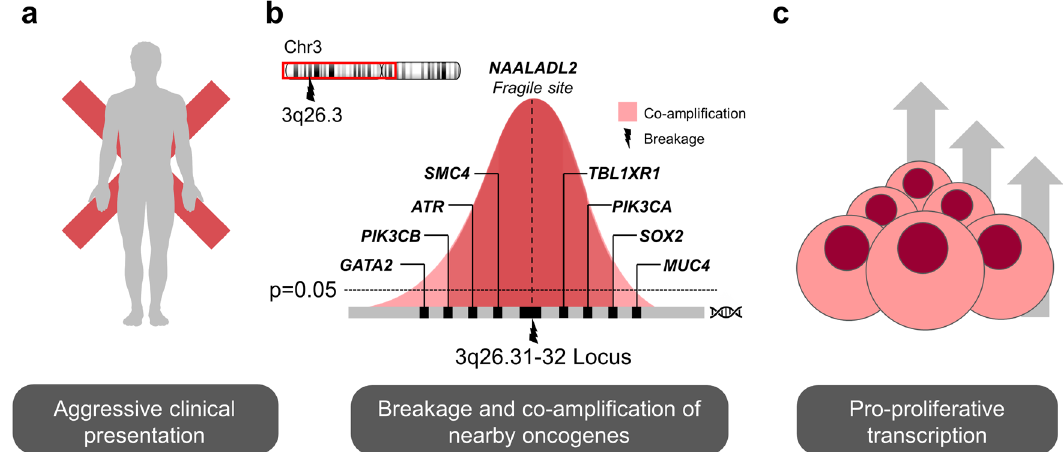
Fig. 1 Overview of evidence surrounding the fragile site NAALADL2 ’ s association with aggressive PCa. a The Frequency of NAALADL2 ampli fi cations increases with Gleason grade, tumour stage and local metastasis in PCa. b Upper: Location of NAALADL2 on Chromosome 3; The lightning symbol indicates the location of the fragile site. The red box indicates the extent of the region that can co-amplify with the NAALADL2 genomic region surrounding 3q26.31, which is rich in oncogenes. Lower: pictograph displaying nearby oncogenes co-ampli fi ed with NAALADL2 in PCa. The x-axis shows the genomic location of genes within the amplicon, the y -axis represents signi fi cant co-occurrence ( − Log10 p- value). c Increased copy number results in increased transcription of oncogenes through the ‘ gene dosage ’ effect as well as downstream activation of other oncogenes. The diagram shows tumour cells replicating following a number of pro-proliferative mRNA signalling pathways becoming